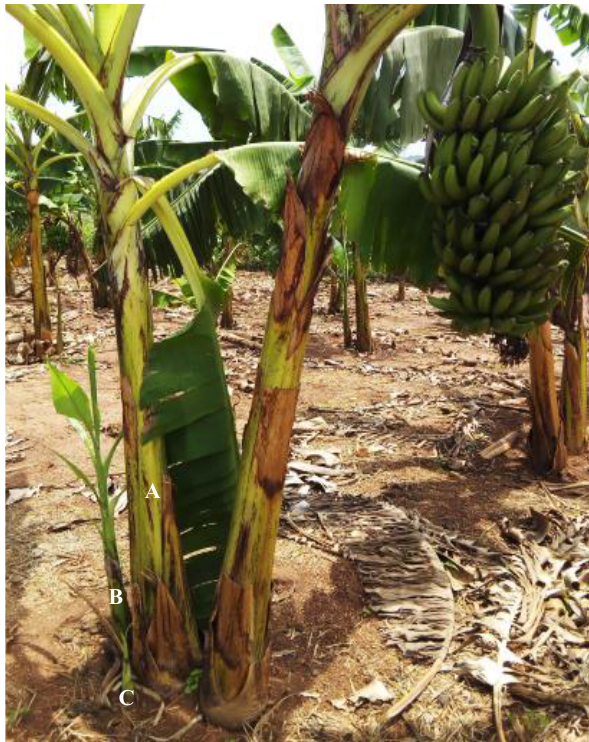
Figure 2: Different sucker types: A = maiden sucker, B = sword sucker, C = peeper